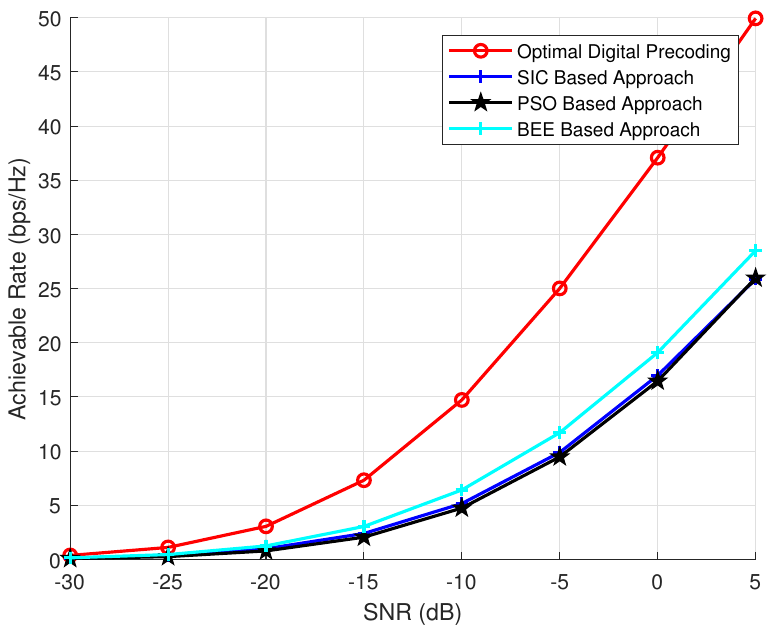
Figure 3. Simulations using N T = 64, N R = 16, N rf =